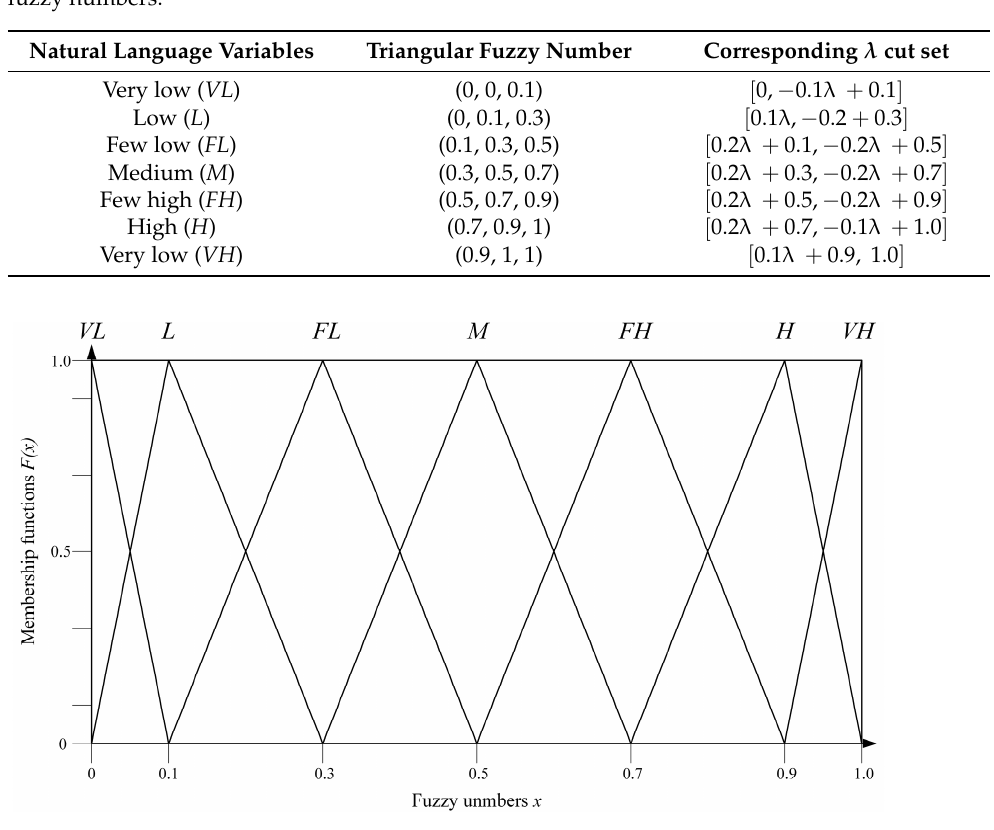
Table 5. Demographics of the respondents.